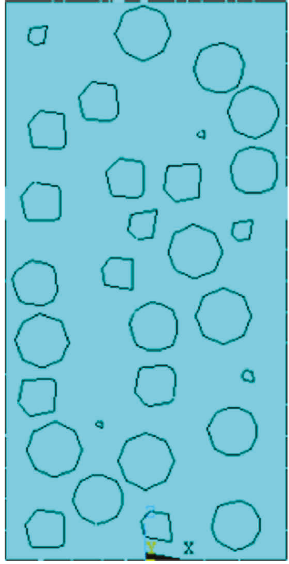
Figure 4: Section of the contact